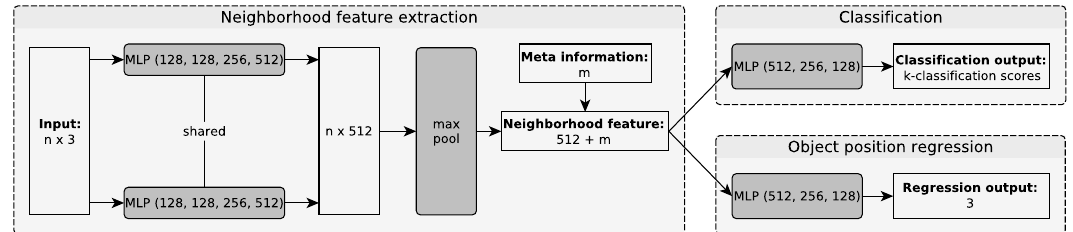
Figure 2. The proposed topology of the neural network. The main input are the n 3D points of a local point neighborhood. m meta information values are a supplemental input. Outputs are classification scores for k classes and estimated 3D coordinates of the object’s center. Batch normalization is used for all MLP ( muli-layer perceptron ) layers, except for the layer directly before the output layer. The last batch normalization of each output is followed by a dropout layer with a dropout rate of